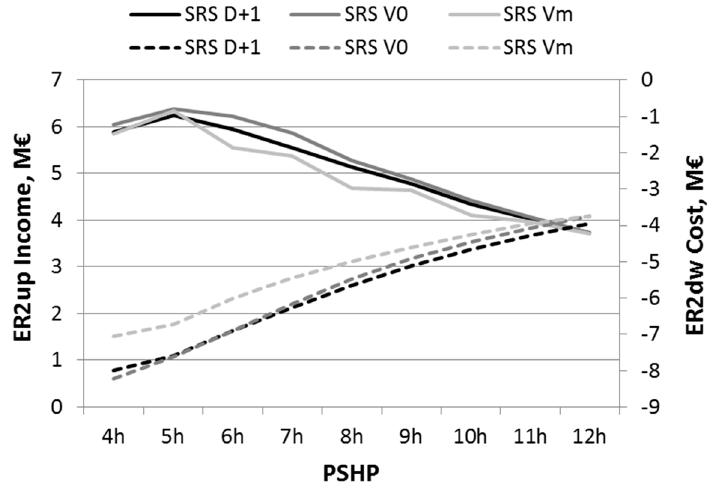
Figure 9. Annual maximum theoretical income due to the real-time use of the upward (ER2up, solid lines) and the downward (ER2dw, dashed lines) reserves of each PSHP.